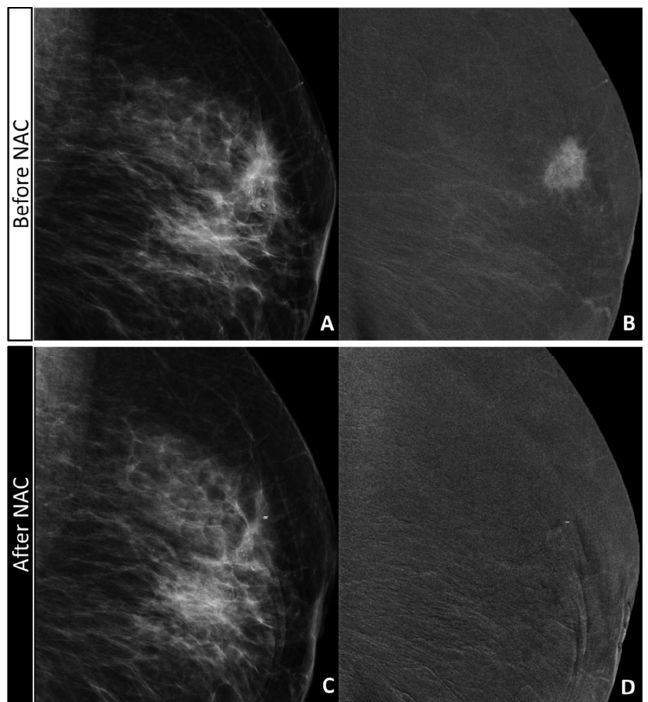
Figure 5. Inter-reader discordance in the evaluation of calcifications: 54-yo woman with IDC G3 HER2+ with opacity and nearby calcifications in left breast ( A , B : medio-lateral-oblique (MLO) low-energy image). The in situ component was seen both on the initial biopsy and on the surgical specimen. For Reader 1, the calcifications after NAC remained pleomorphic and were considered as the measurement of the residual disease because more extensive (114 mm; C ) than the concomitant faint residual rim enhancement (10 mm; D : MLO recombined image). For Reader 2, the same patient presented with a cluster of 15 mm of indeterminate calcifications after NAC ( C ), and thus considered CE only for the measurement of residual disease (10 mm; D ). The analysis of surgical specimens reveled 15 mm of IDC and DCIS, with a better concordance for Reader 2 vs. Reader